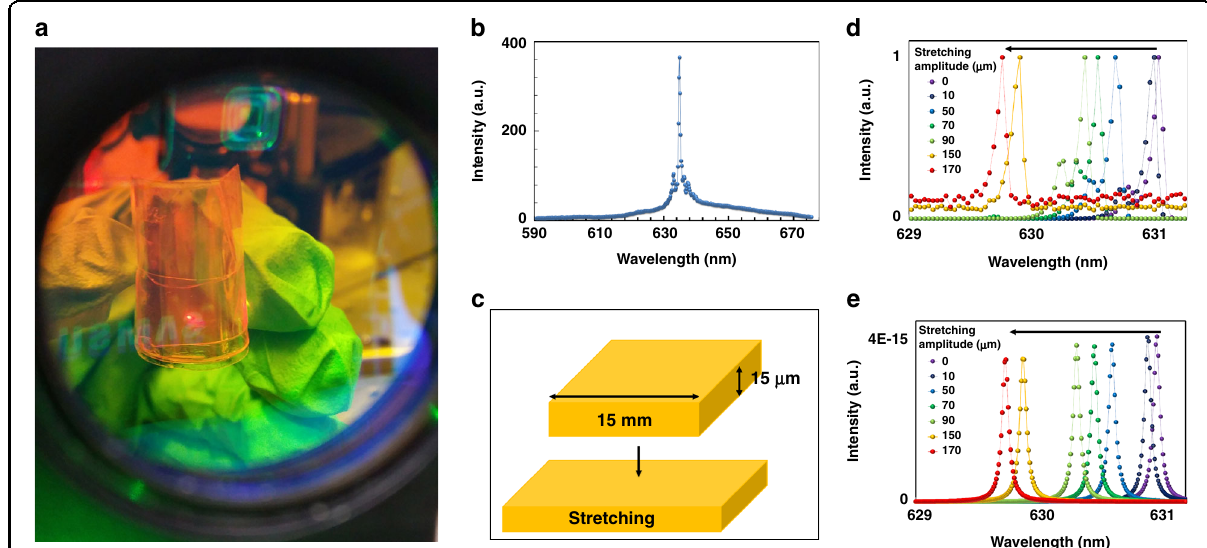
Fig. 4 Lasing emission of bend and stretched QDCLC fi lms. a Photograph and b Emission spectrum of a bent QDCLC laser on an adhesive fi lm. c Illustration of how the free-standing QDCLC fi lm with a thickness of 15 µm and a length of 15 mm is stretched to increase the length by 170 µm. d Emission spectra of the stretched laser with various stretch amplitudes and e corresponding simulation in which the thickness of the layers is reduced proportionally with the stretching